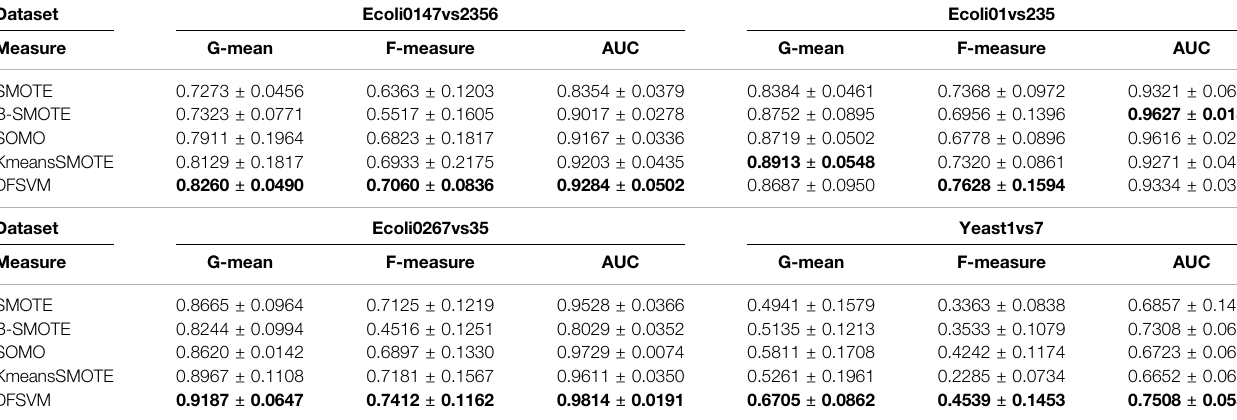
TABLE 5 | The experimental results of different sampling